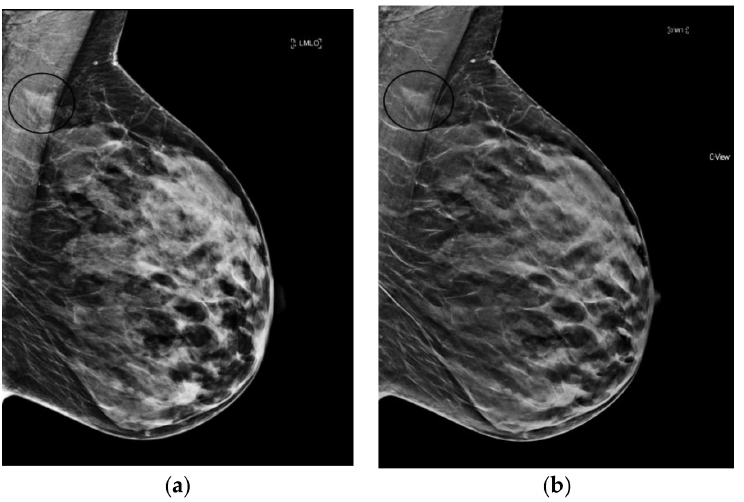
Figure 5. Indeterminate asymmetry seen on 2D FFDM is less prominent on synthesized mammography and resolved on DBT slices; no recall was necessary. ( a ) 2D FFDM ( b )